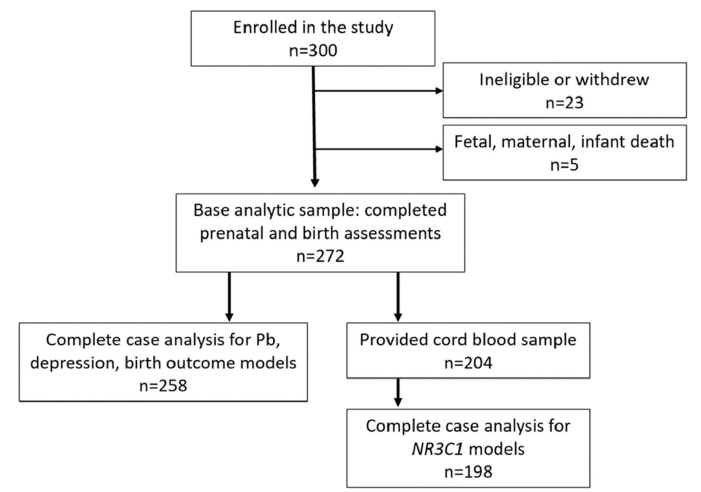
Figure 1. Albany Infant and Mother Study participation.